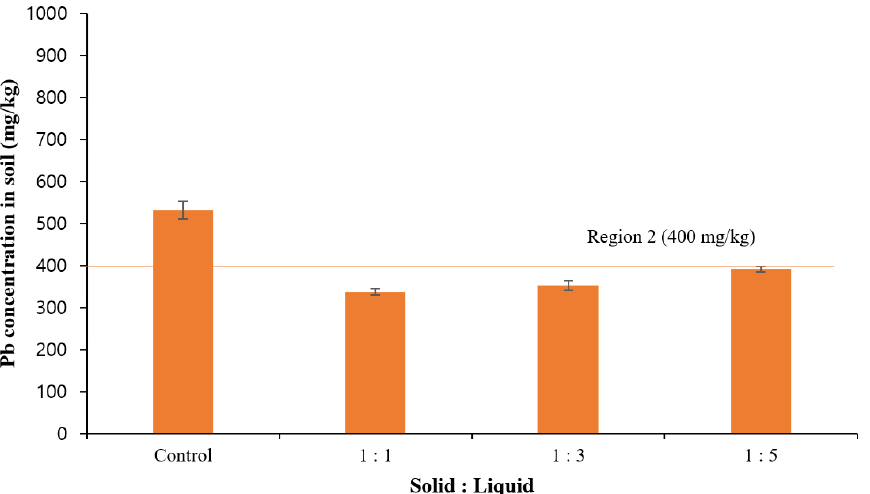
Figure 7. Pb concentrations remaining in the soil using a solid-liquid ratio of 1:1, 1:3 and 1:5 for the washing of soil.